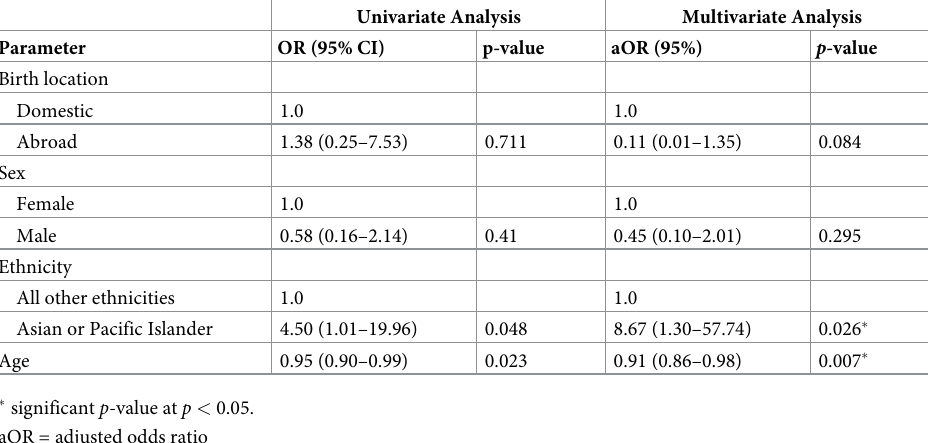
Table 3. Logistic regression model for cases from 1995 to